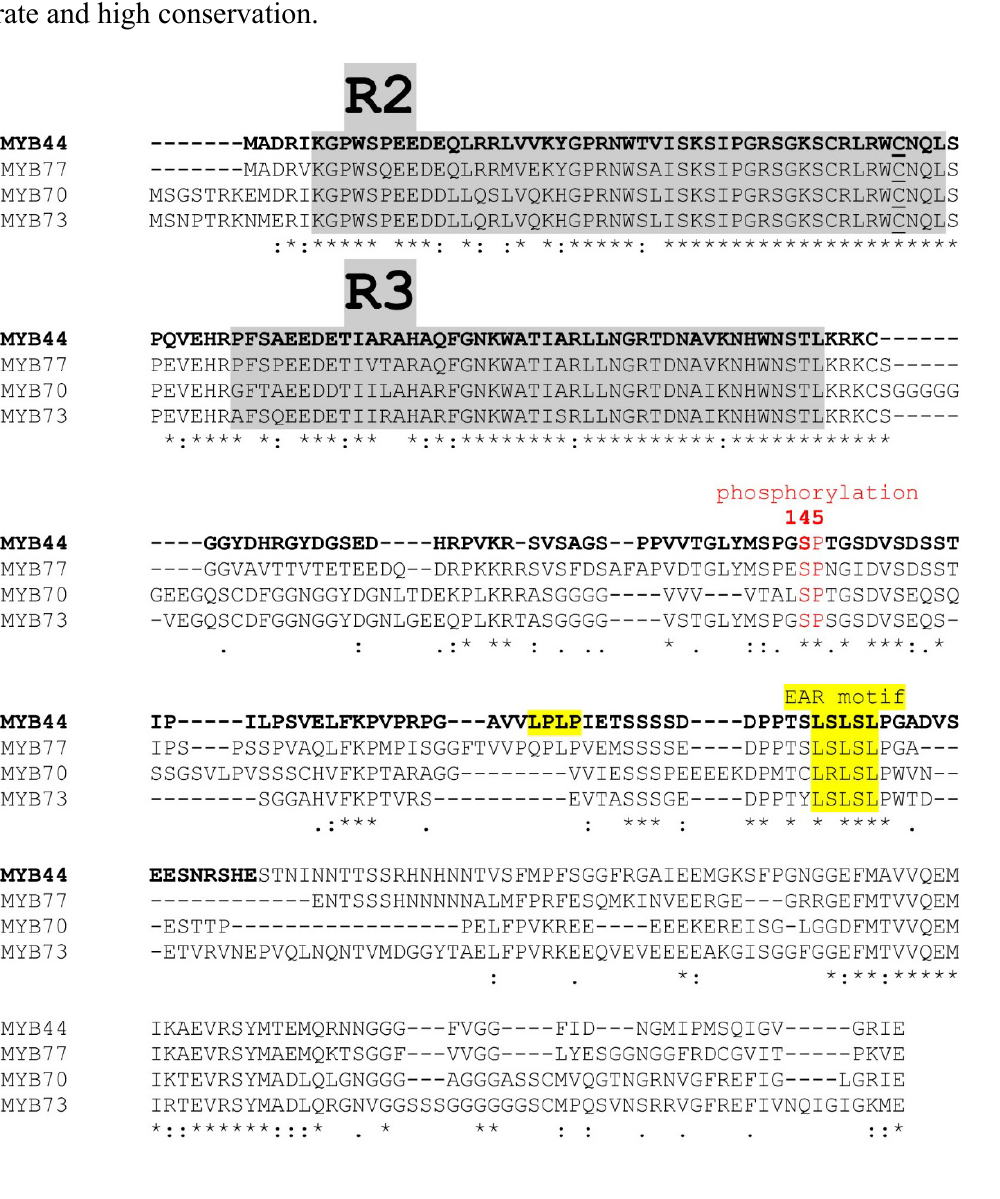
Figure 1. Protein sequence alignment of Arabidopsis R2R3 MYB subfamily 22. The R2R3 repeats of the DNA binding domain (grey) and putative transcriptional repressor motif (yellow) are highlighted. The known MPK3 phosphorylation site in MYB44 (Ser145) is indicated. The N -terminal (aa1-212) MYB44 region known to bind particularly strongly to DNA (MBSII element) is shown in bold. A conserved cysteine residue potentially involved in redox-dependent MYB activity is underlined. “.” “:” and “ * ” mark residues with low, moderate and high